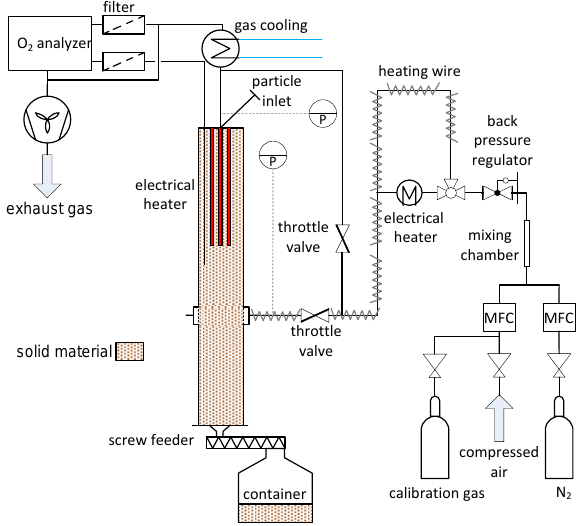
Figure 3. Flow diagram of the reactor